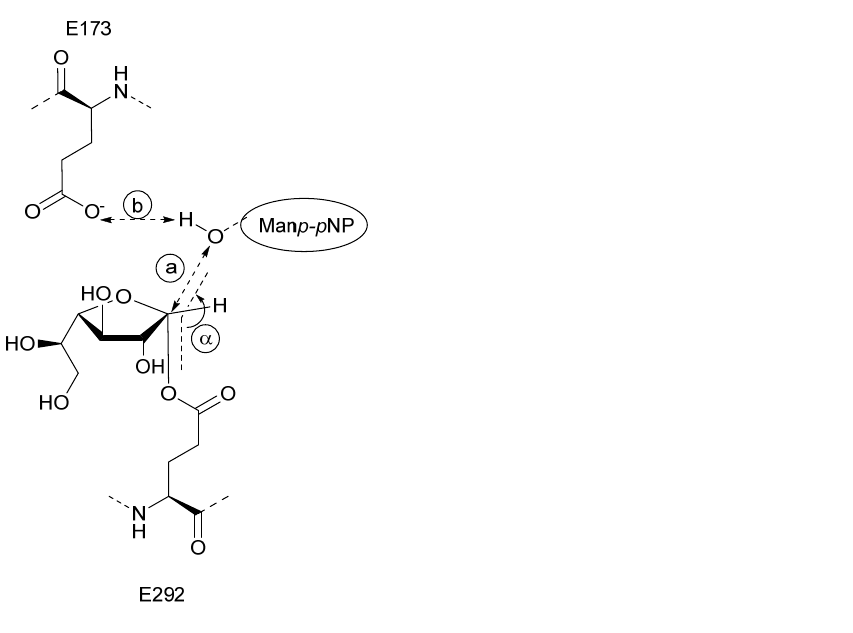
Table 2. MD simulation parameters to study (1 → X) regioselectivity of Man p - p NP approaches. Distances a X are depicted in Scheme 2. When shorter distances a X were observed with other hydroxyl (OH) than the initial one, they were added between